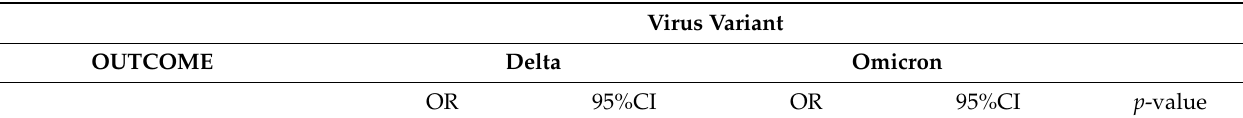
Table 3. Multiple logistic regression analysis of association of CT-graphic pulmonary manifestations and virus variant.